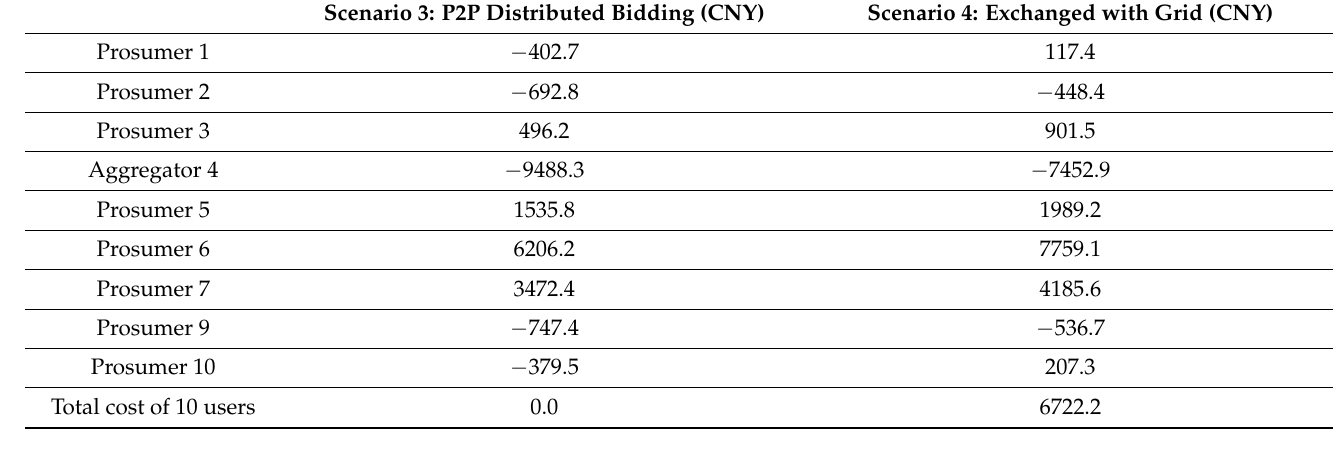
Table 9. The cost comparison of the successfully traded exchange power for 24 h under two scenarios.